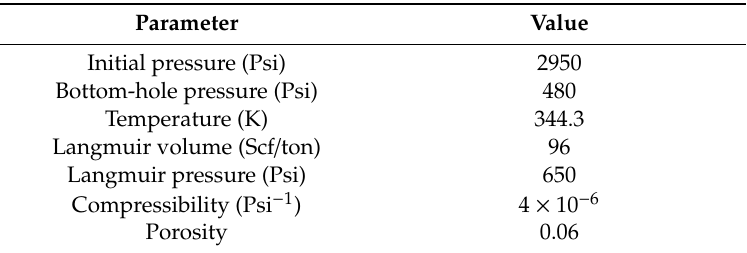
Table 6. Summary of the reservoir parameters for analysis.